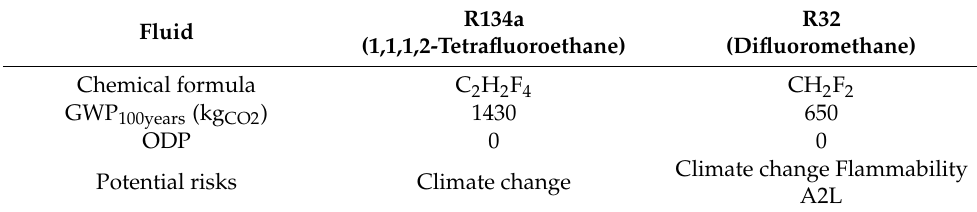
Table 2. Characteristics of HFCs R134a and R32.